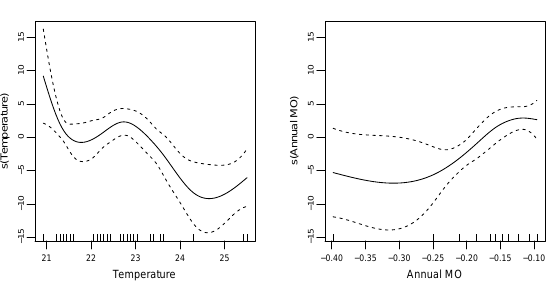
Figure 5 – Fitted Temperature and Annual MO smooth effects of the median length for A.